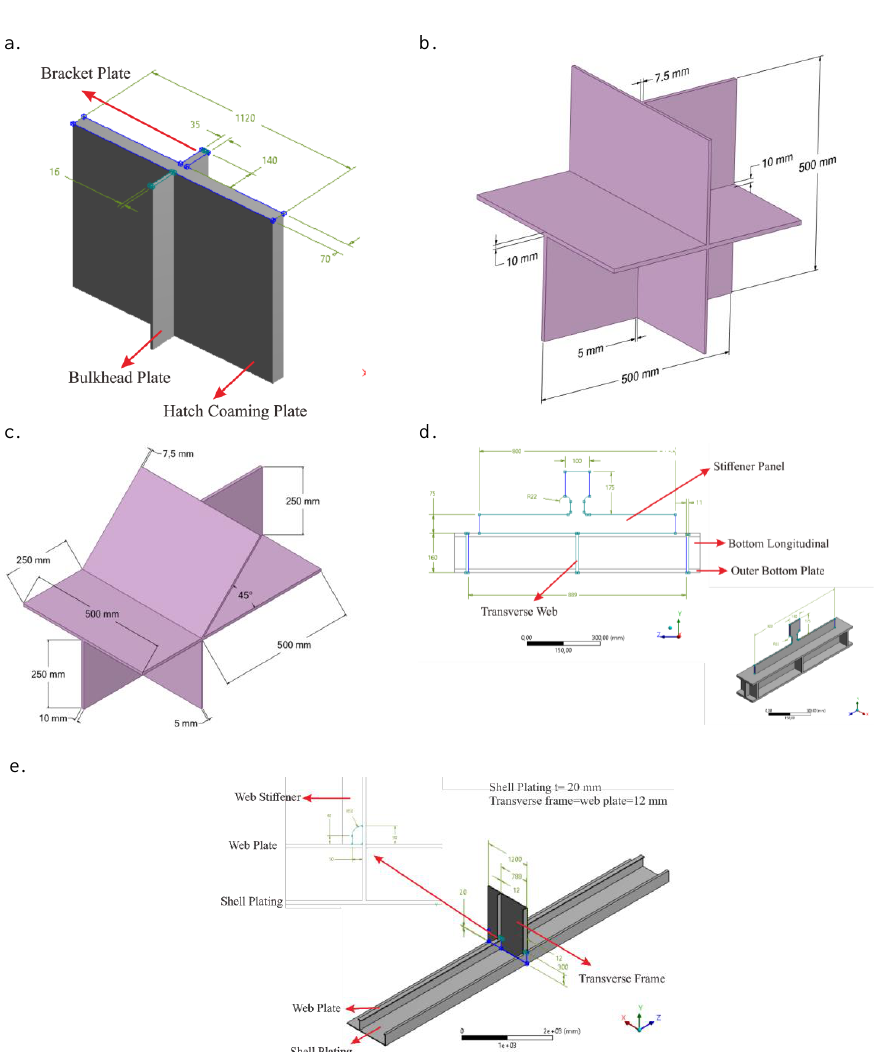
Figure 5. Geometry Model: a. Geometry 1: Hatch Coaming Model [16]; b. Geometry 2: Perpendicular Joint [12]; c. Figure 5: Geometry model: a. Geometry 1: Hatch coaming model [16]; b. Geometry 2: Perpendicular joint [12]; c. Geometry 3: Stool joint [12]; Geometry 3: Stool Joint [12]; d. Geometry 4: Bottom-Stiffened Panel [27]; e. Geometry 5: Side-Stiffened Panel [28] d. Geometry 4: Bottom-stiffened panel [28]; e. Geometry 5: Side-stiffened panel